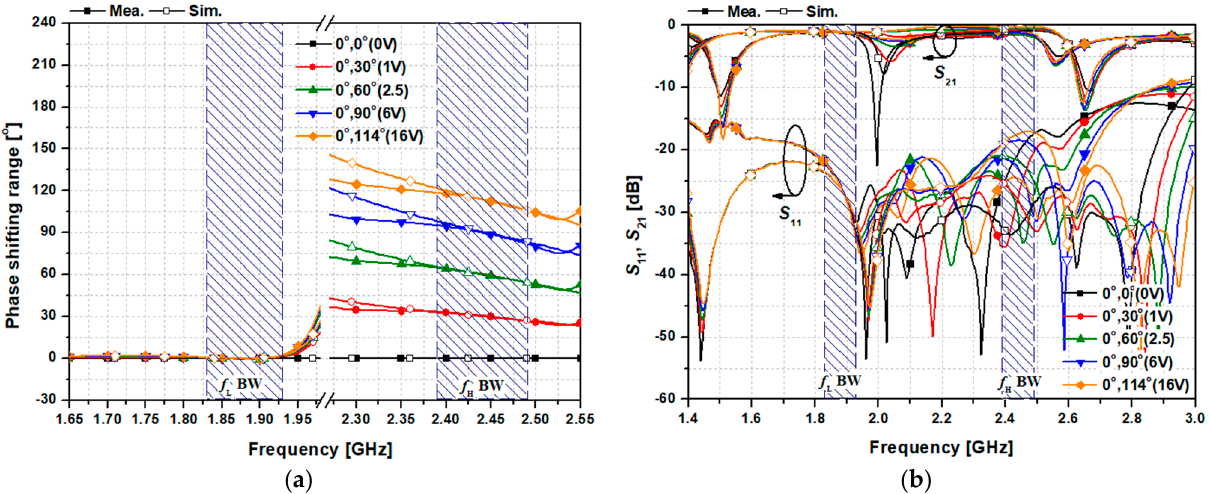
Figure 10. Simulated and measured results of a dual-band PS achieved by varying the bias voltage of